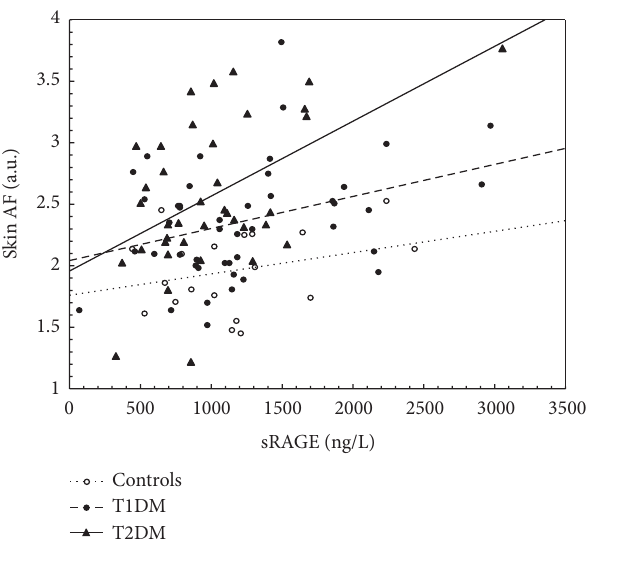
Figure 2: Relationship of skin AF and sRAGE in controls, T1DM and T2DM.